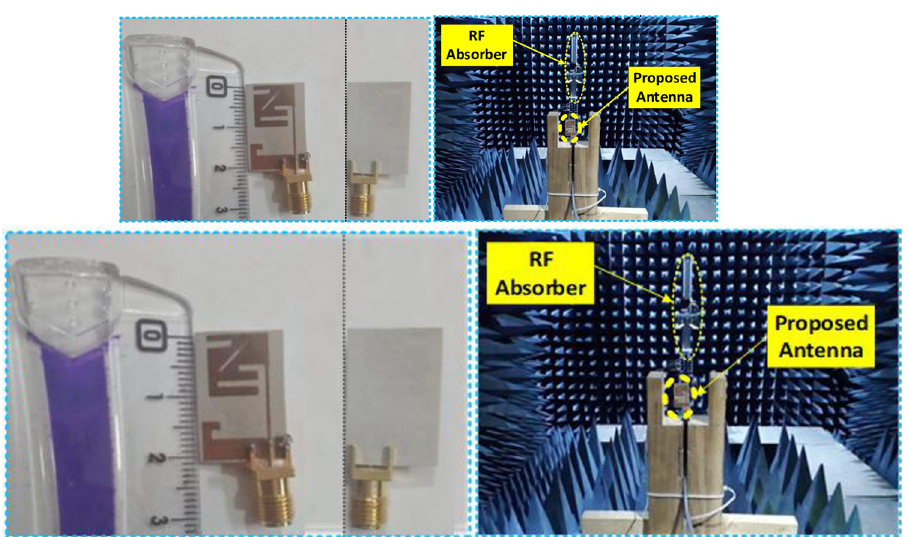
Fig 5. A top view, a bottom view, and a configuration of the antenna within an anechoic chamber are shown for the prototype antenna that was manufactured. https://doi.org/10.1371/journal.pone.0280042.g005 circular polarization, the current flows around the printed monopole in a round pattern. Fig 8 illustrates the contrast of the simulated and observed axial ratios and the peak gain graph. An antenna’s axial ratio bandwidth in free space can be clearly seen from Table 3 and the graph, which shows that while the simulation antenna covers 47.3% of this bandwidth in free space,